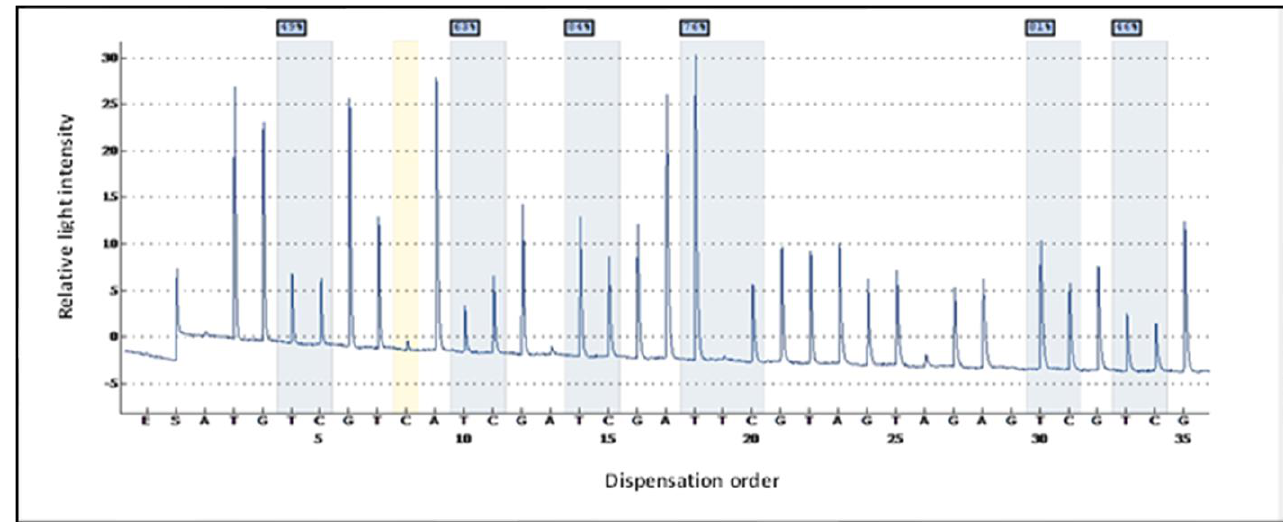
Figure 1: Pyrogram of methylation level of the six CpG sites in the TFAP2E gene promotor (The 6 blue-gray shaded areas of the pyrogram correspond to the 6 CpG sites interrogated in TFAP2E gene promotor; X axis: Dispensation order, Y-axis: Relative light